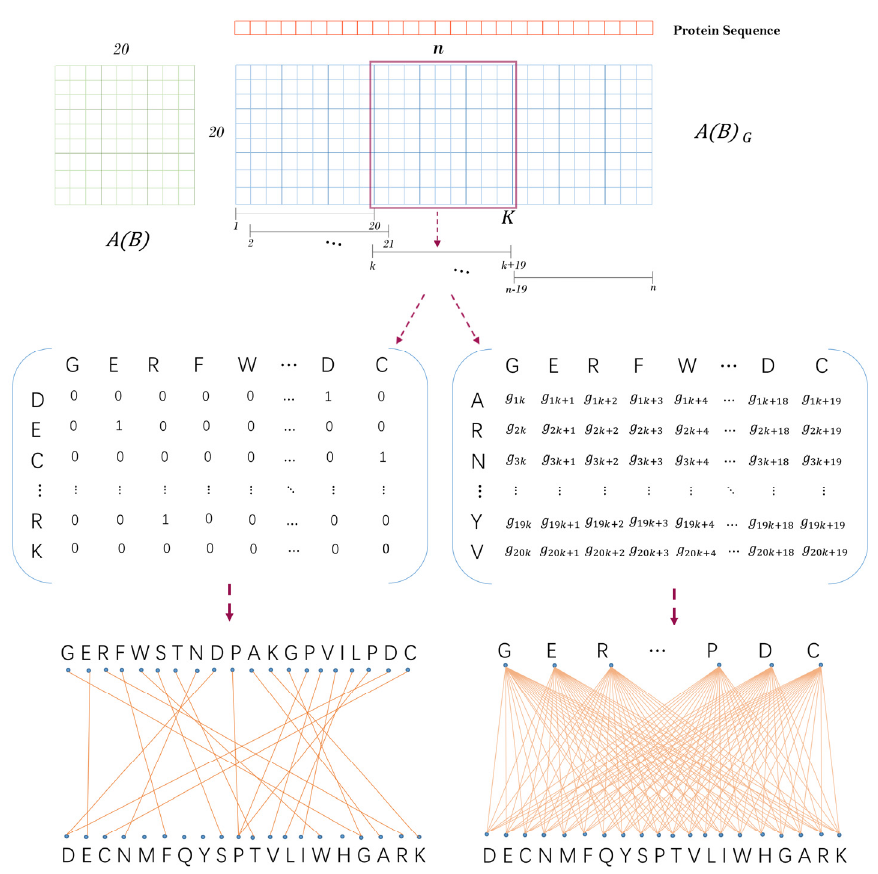
Figure 8. The schematic diagram of protein sequence feature extraction.